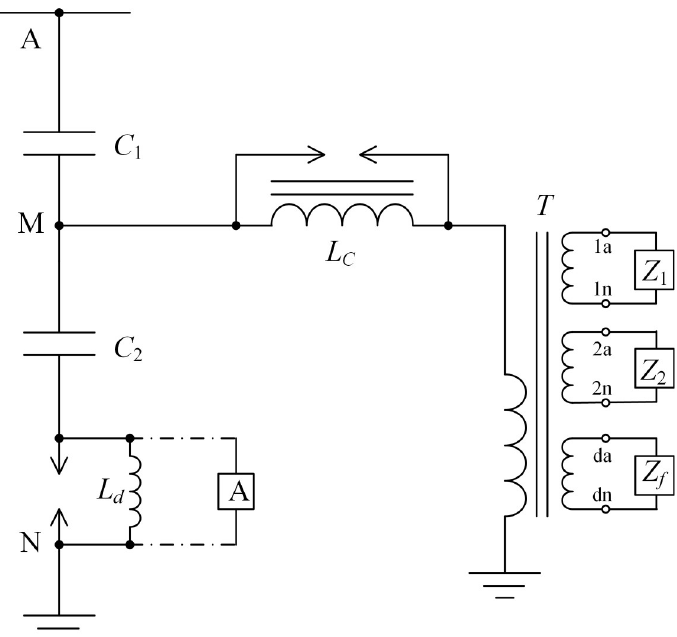
Fig 1. Structure of the CVT